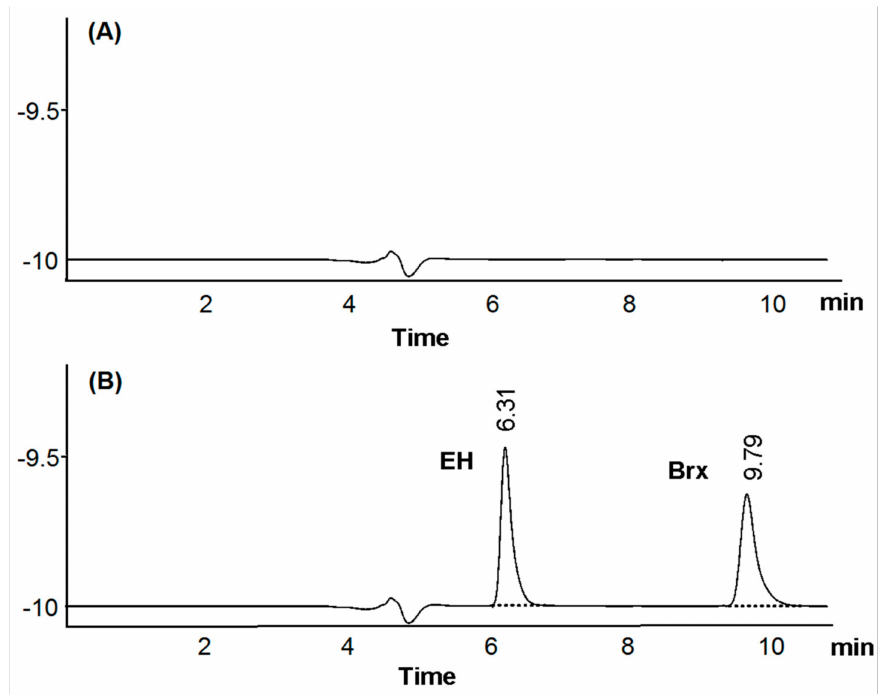
Figure 4. HPLC chromatogram of ( A ) blank matrix of ointment and ( B ) ointment sample.